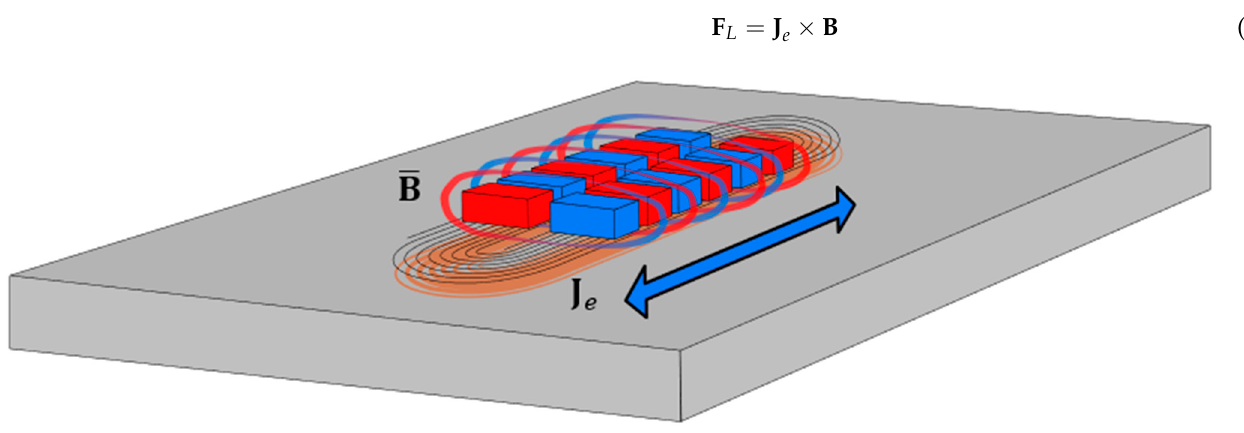
Figure 1. Lorentz force diagram of a typical bidirectional PPM EMAT. Shown are the induced eddy currents in orange, magnetic flux density surrounding the magnets and the direction of propagation of the generated guided waves depicted by the blue arrow.